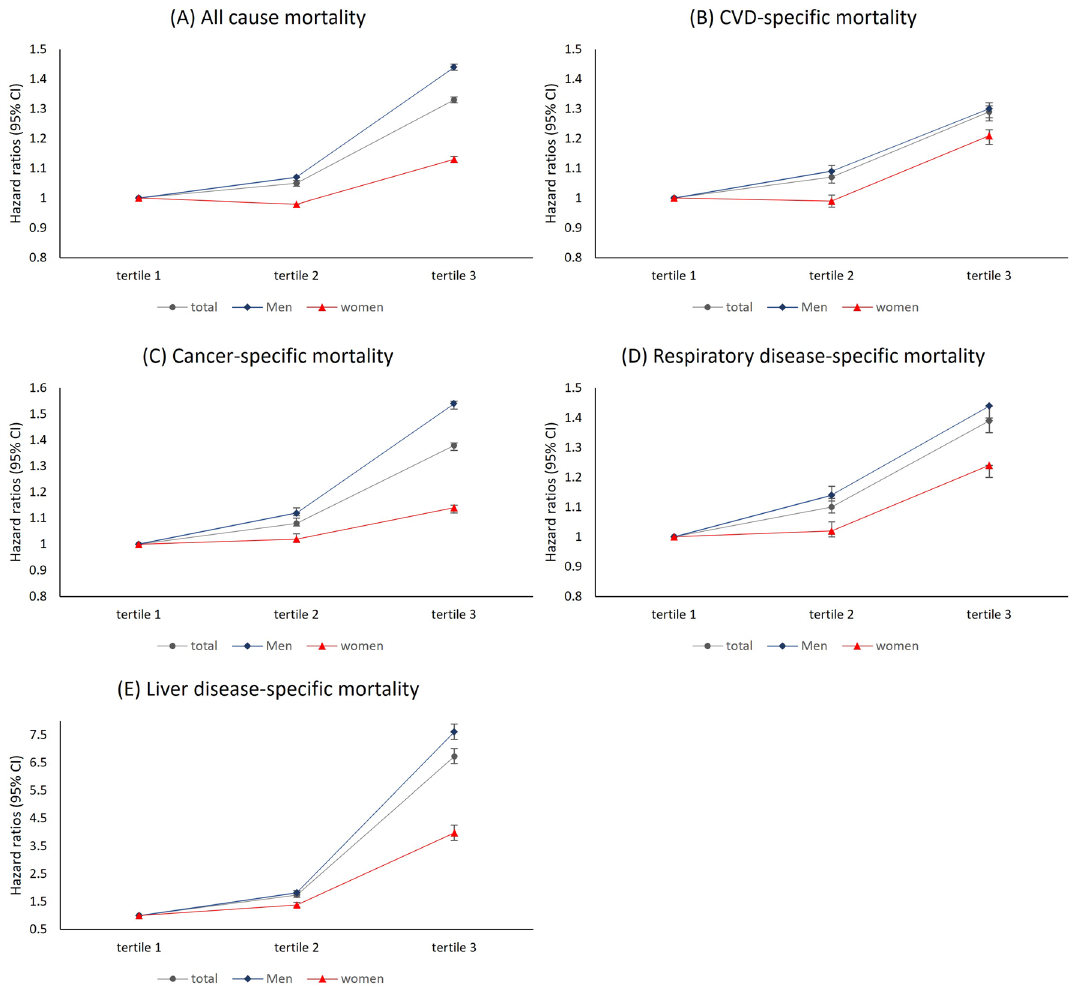
Figure 2. Hazard ratios (95% confidence intervals) for ( A ) all-cause, ( B ) cardiovascular disease-, ( C ) cancer-, ( D ) respiratory disease-, and ( D ) liver disease-specific mortality according to tertile of serum gamma-glutamyl transferase